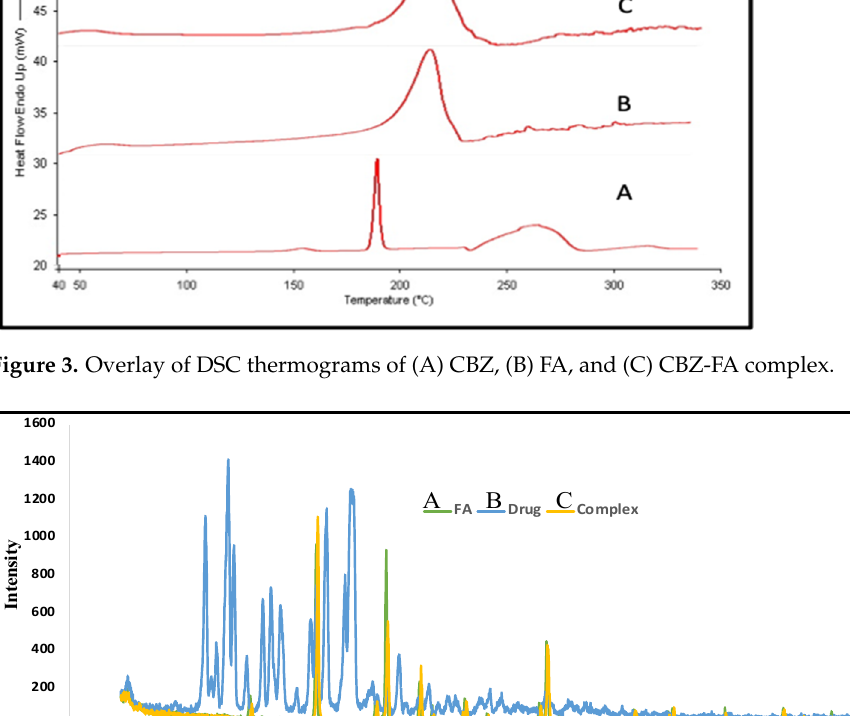
Figure 3. Overlay of DSC thermograms of (A) CBZ, (B) FA, and (C) CBZ-FA complex.